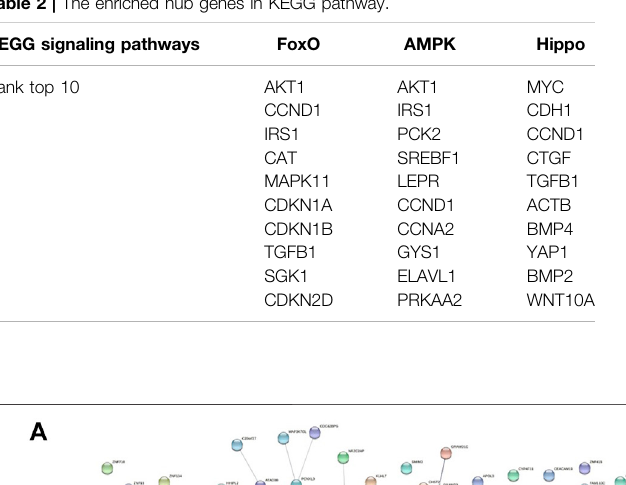
Table 2 | The enriched hub genes in KEGG pathway.